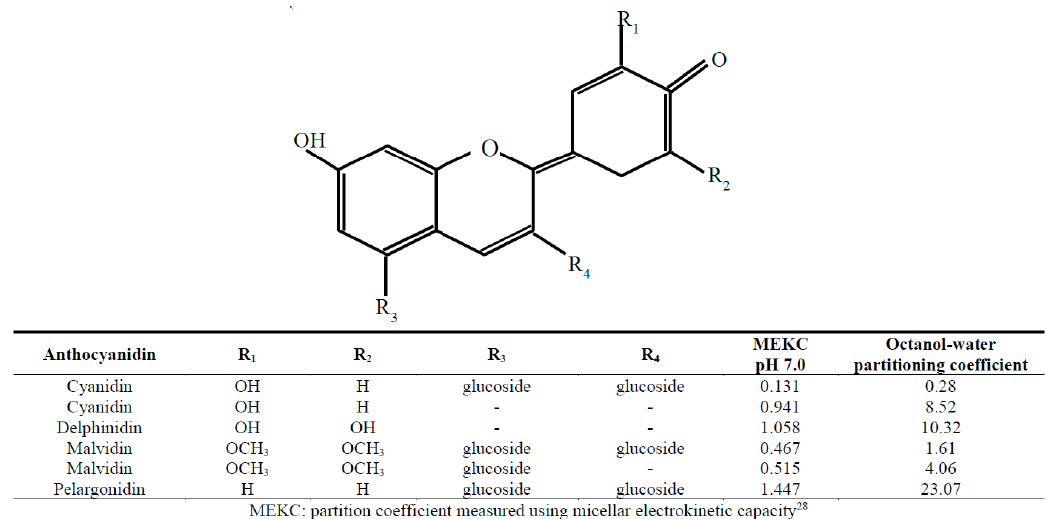
Figure 2. Partition coefficients of selected anthocyanidins and anthocyanins based on micellar electrokinetic methods and octanol-water partitioning [28].